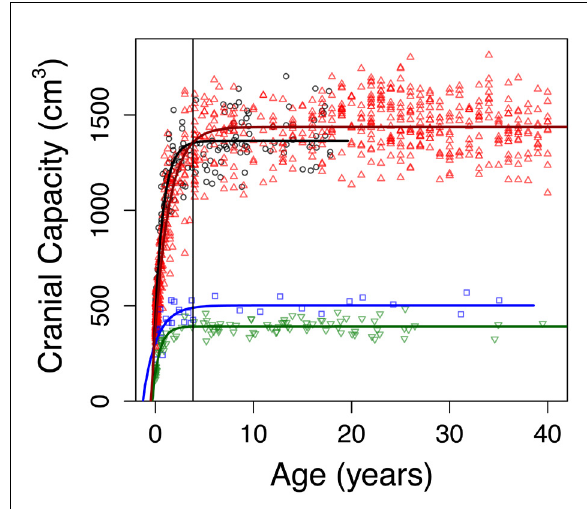
Figure 1: Distance growth curves for two samples of modern humans (black open circles, red triangles), chimpanzees (green triangles) and gorillas (blue squares) used to model Taung’s cranial capacity growth. The vertical line indicates Taung’s estimated age of 3.83